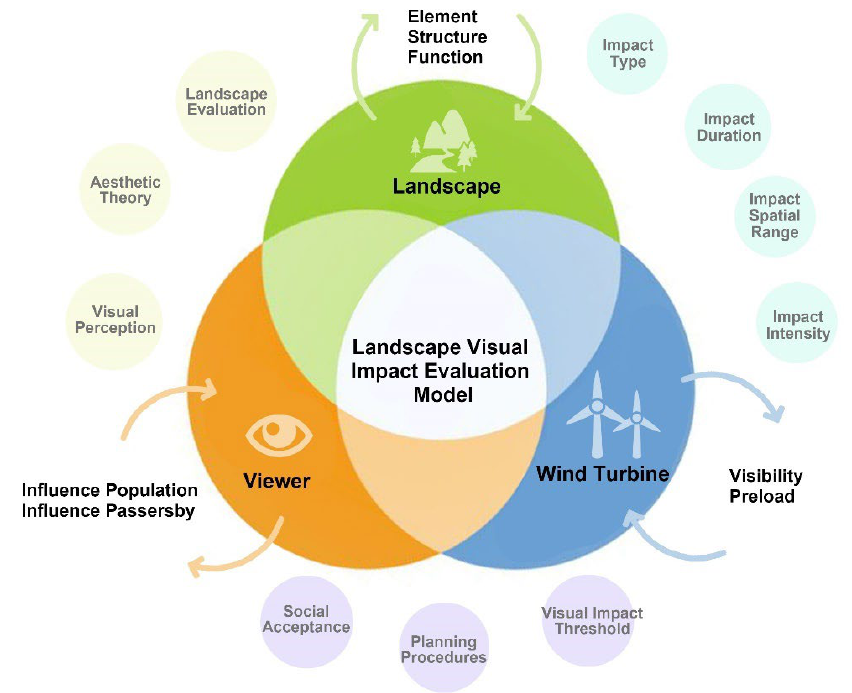
Figure 1. The theoretical framework of landscape visual impact